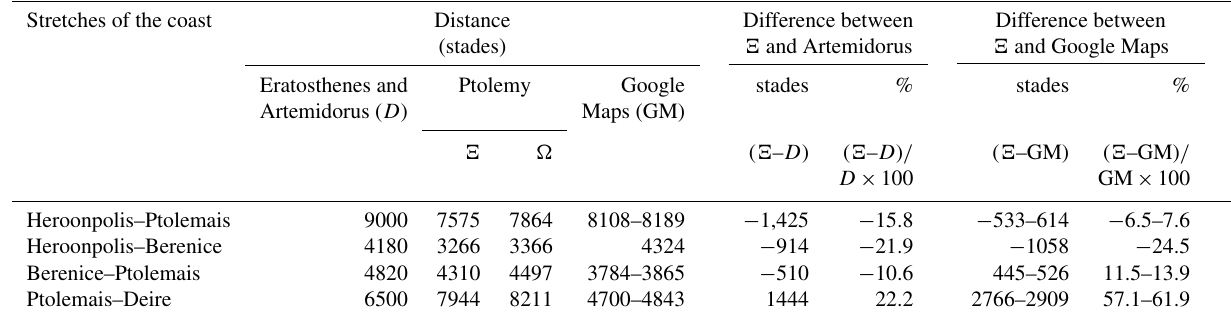
Table 3. Length of the Red Sea coast according to Artemidorus, Eratosthenes, Ptolemy, and measurements using Google Maps (Google Inc., 2017). All distances are expressed in stades; 1 stade = 185 m. Stretches of the coast Distance Difference between Difference